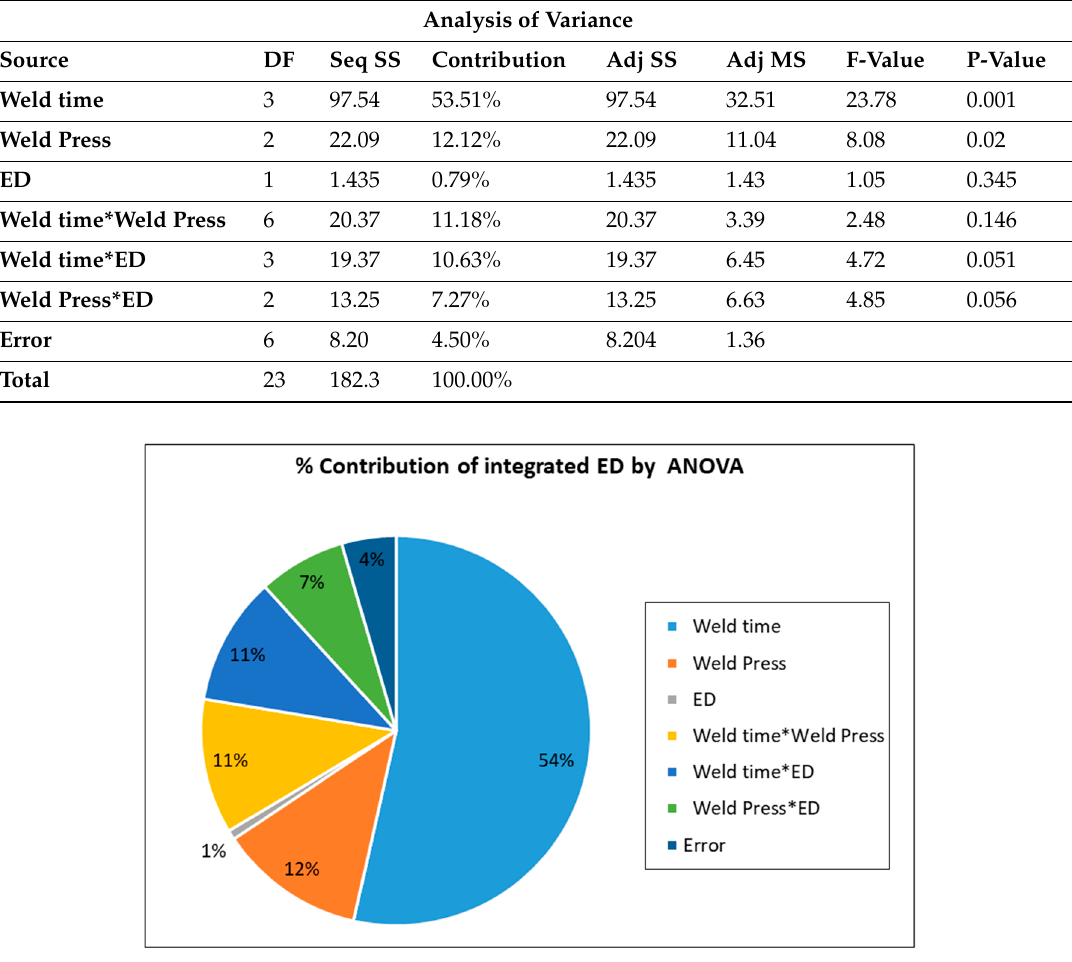
Figure A.1. %Contribution of weld parameters for integrated ED film by ANOVA. Figure A1. %Contribution of weld parameters for integrated ED film by